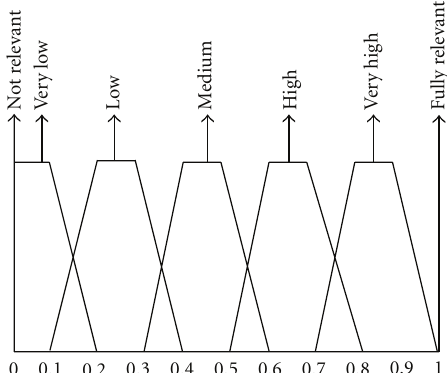
Figure 1: The membership function of linguistic